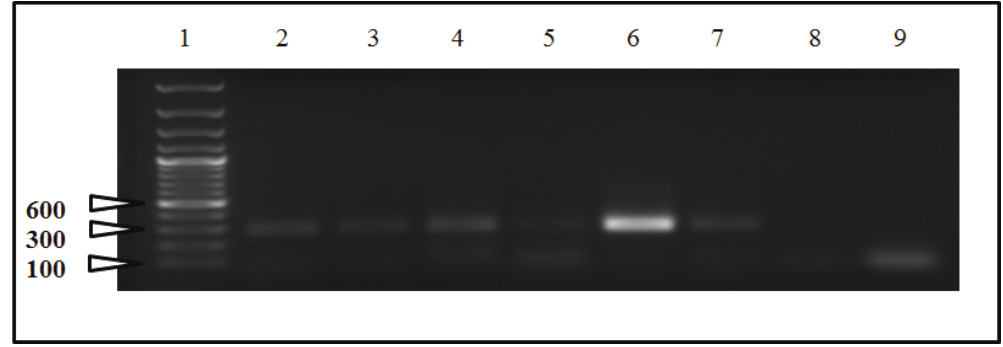
Figure 2. Nested PCR agarose gel electrophoresis of samples derived from ovine tissues. Lane 1, molecular weight markers; lane 2, carpal joint synovium; lane 3, brain stem; lanes 4 and 5, spinal cord; lane 6, lung; lane 7, mammary gland; lane 8, negative control 1 (water template, 1st PCR); lane 9, negative control (water template, 1st and 2nd PCR-nested). Lanes 2 through 7 contain appropriate-sized amplicons (~300 bps). Only lane 6 (lung) yielded PCR product in the initial PCR (data not shown). Ethidium bromide-stained